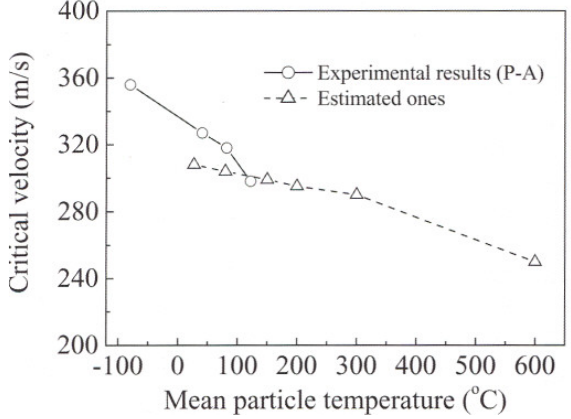
Figure 9: Critical velocity vs. Mean particle temperature [16]